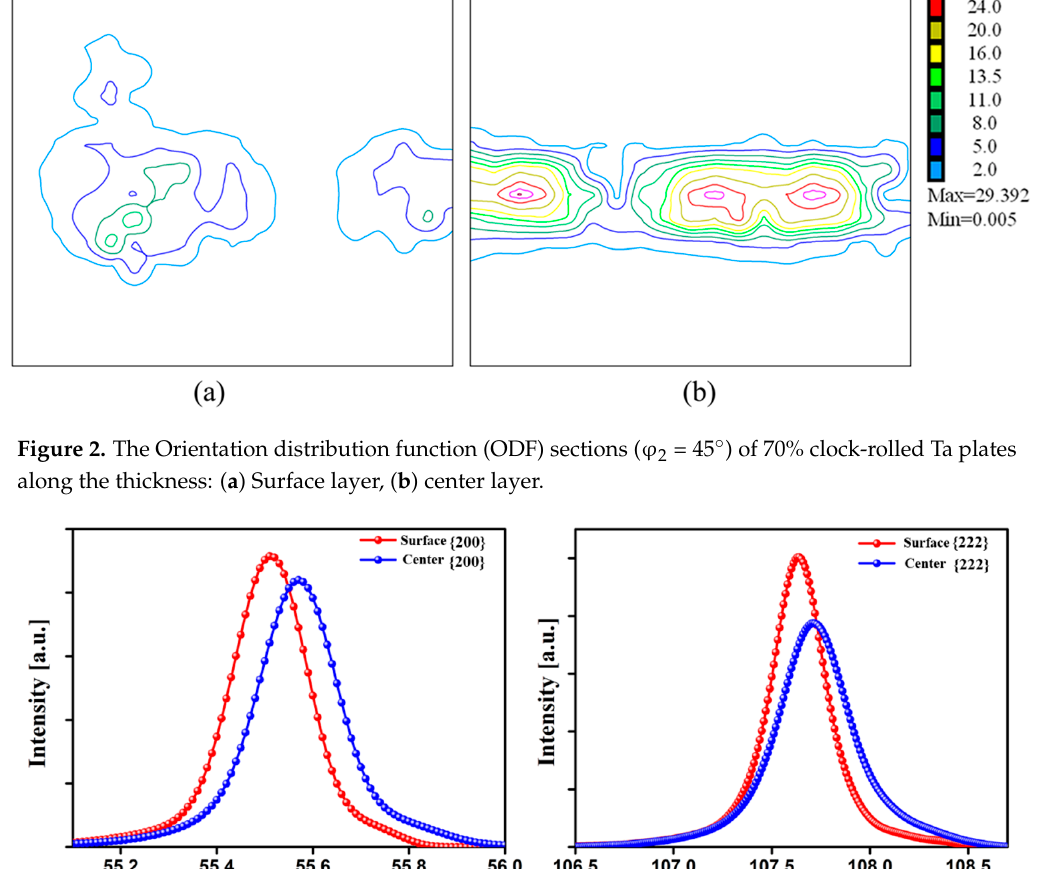
Figure 3. Fitted (200) and (222) diffraction peaks of Ta in the surface and center layers, respectively. ( a ) (200) diffraction peak ( b ) (222) diffraction peak.